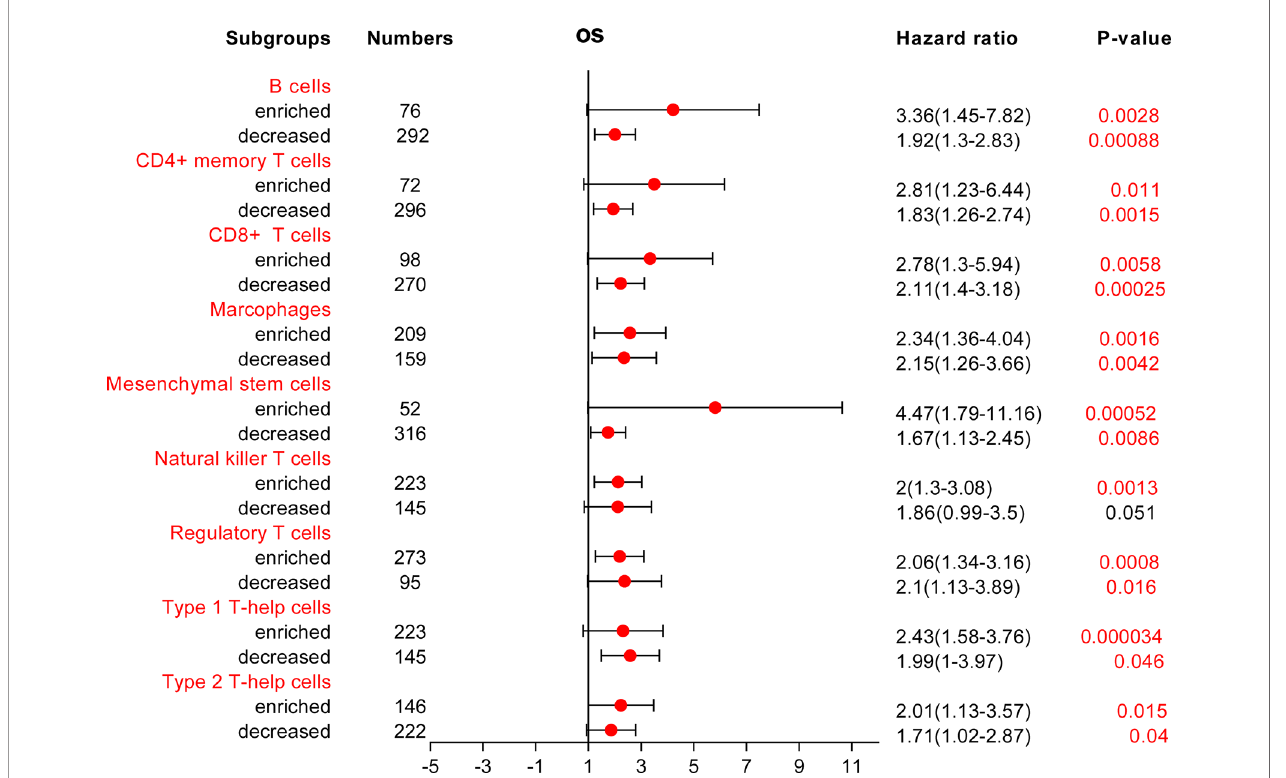
FIGURE 9 | Forest plot of the prognostic value of COMMD2 based on different immune cell subgroups of LIHC